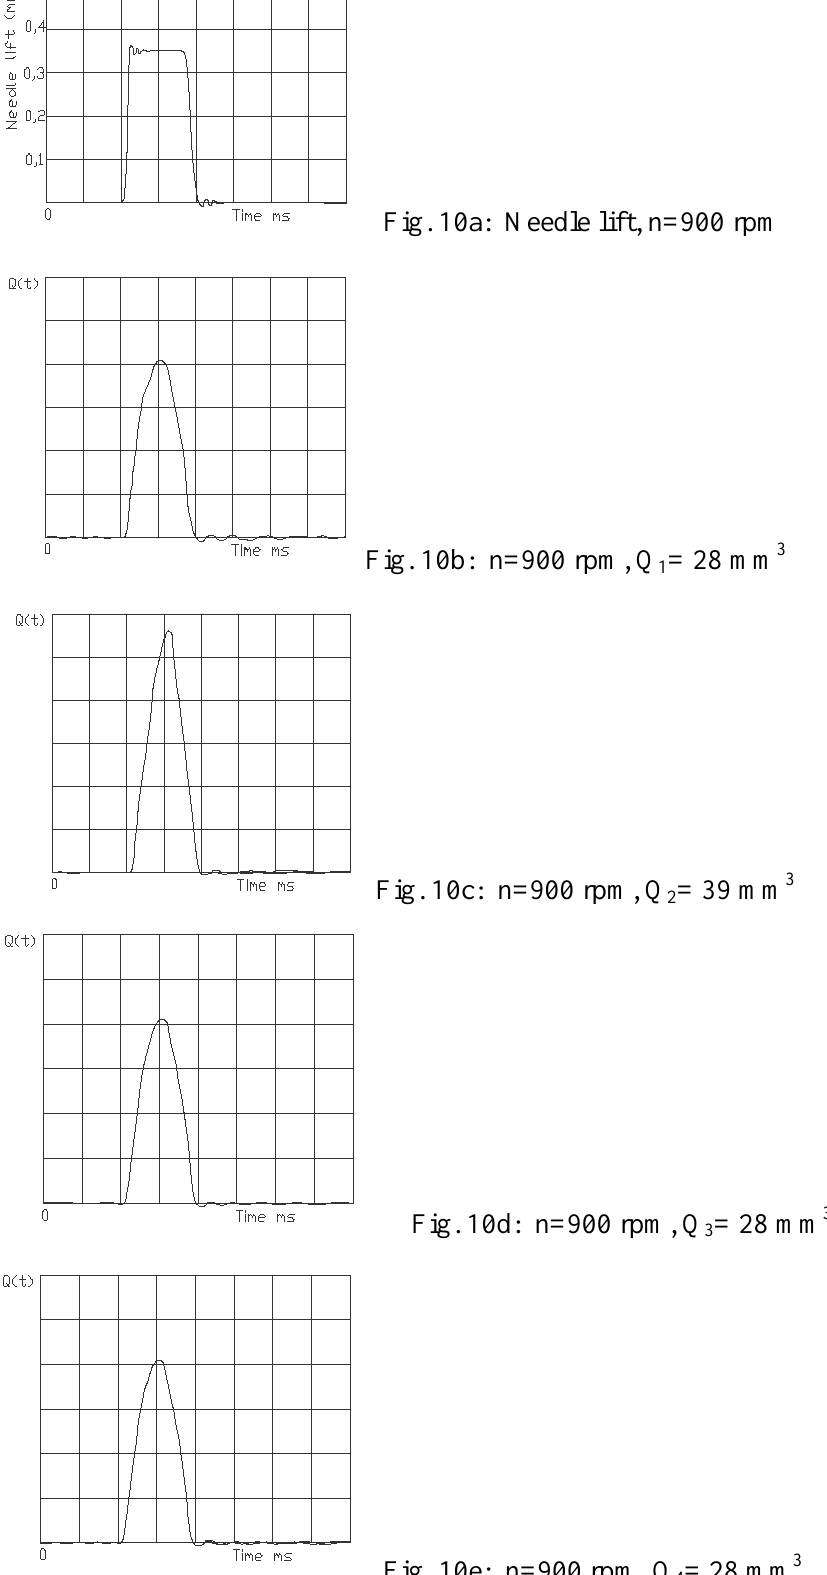
Fig. 10e: n=900 rpm, Q